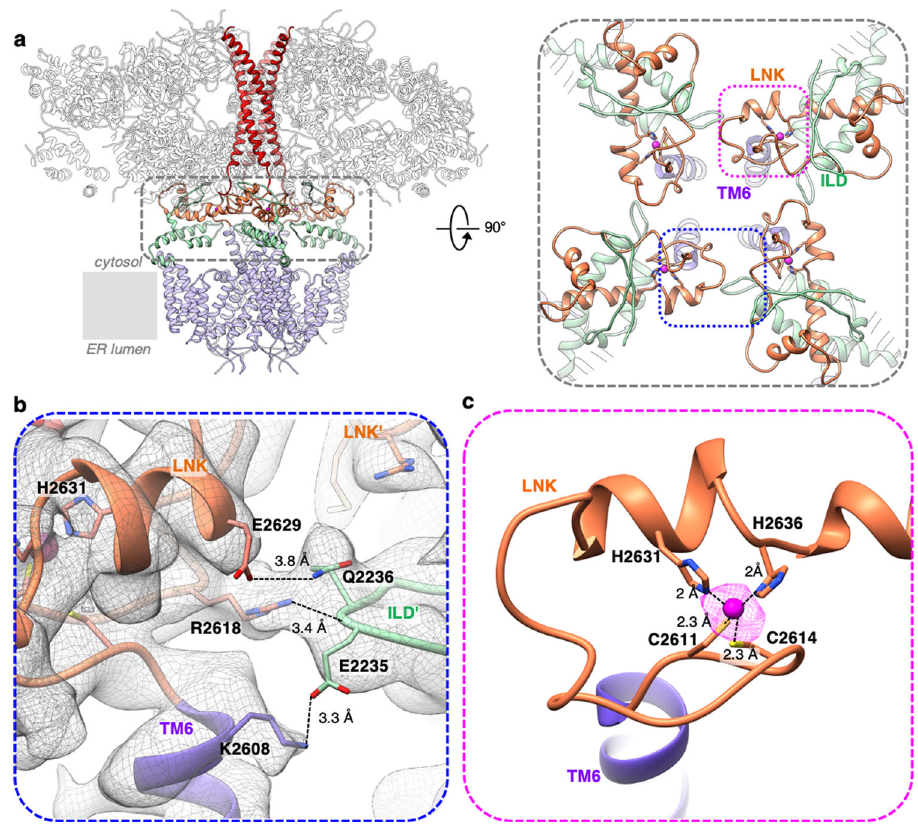
Fig. 4 IP 3 R1 domains at the cytosolic-lipid bilayer interface. a The ILD (light-green) and LNK domain (orange) form a metastable nexus connecting the CY (gray) and TM (purple) regions in the tetrameric IP 3 R1 channel; viewed along the membrane plane. The right panel shows a zoomed-in view of the domains (indicated by the gray dashed line in the left panel) at the cytosolic-membrane interface viewed from cytosol along the four-fold axis. b The interface between ILD and the LNK/TM6 of neighboring subunits overlapped with corresponding EM densities (displayed at 4 σ ). c Close-up view of Zn 2 + binding site in LNK domain; residues in the C2H2-like Zn 2 + fi nger are labeled; the density corresponding to Zn 2 + is depicted as magenta mesh, contoured at 15 σ